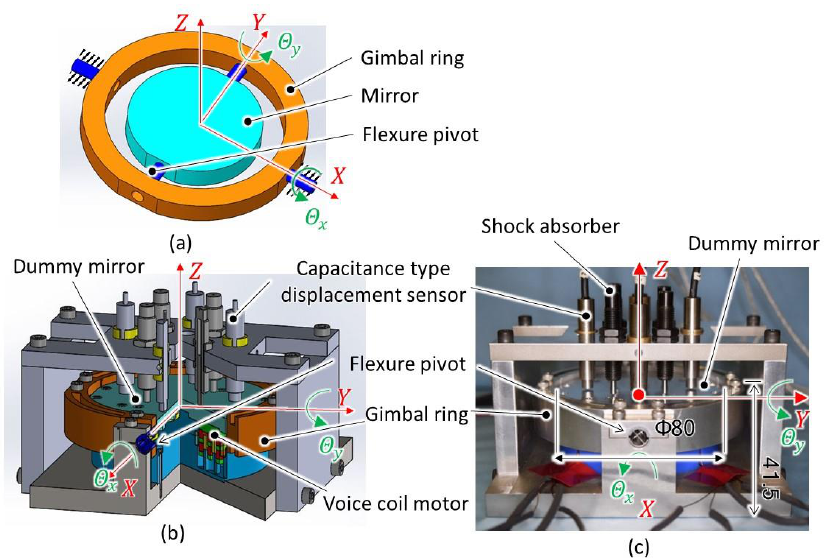
Figure 13. The test rig using a gimbal ring and flexural pivots: ( a ) Configuration of the gimbal mechanism; ( b ) configuration of the test rig; ( c ) photograph of the test rig.